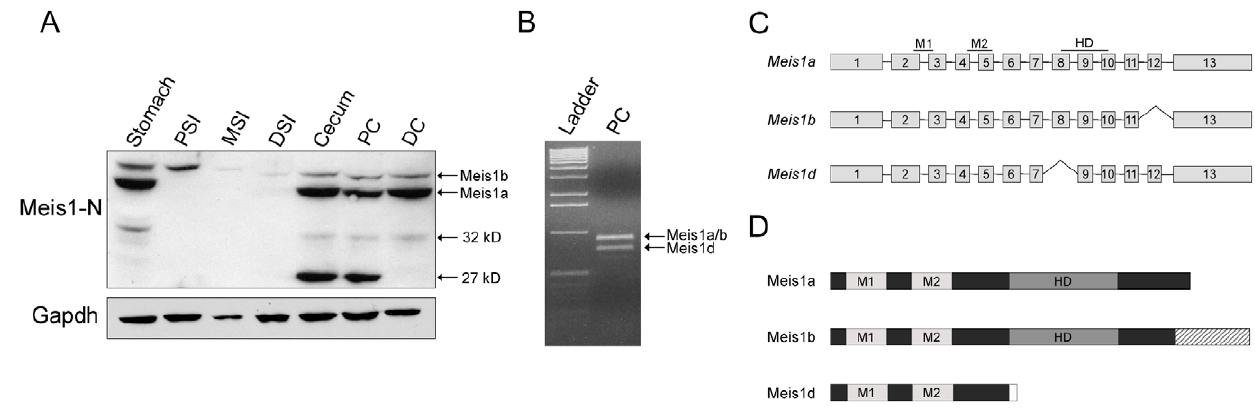
Figure 1. Novel Meis1 isoforms are present in the murine gastrointestinal tract. A) Western blot analysis of B6 gastrointestinal lysates using the Meis1-N antibody. Gapdh was used as a loading control. PSI, MSI, and DSI indicate lysates from the proximal, middle, and distal small intestines, respectively. PC and DC indicate lysates from the proximal and distal colons. B) Amplification of Meis1 isoforms from B6 proximal colon cDNA using RT-PCR. Diagrams of the C) transcripts and D) products of Meis1a, Meis1b, and Meis1d isoforms are included. The locations of the two Meinox domains (M1 and M2) and the homeodomain (HD) are labeled.